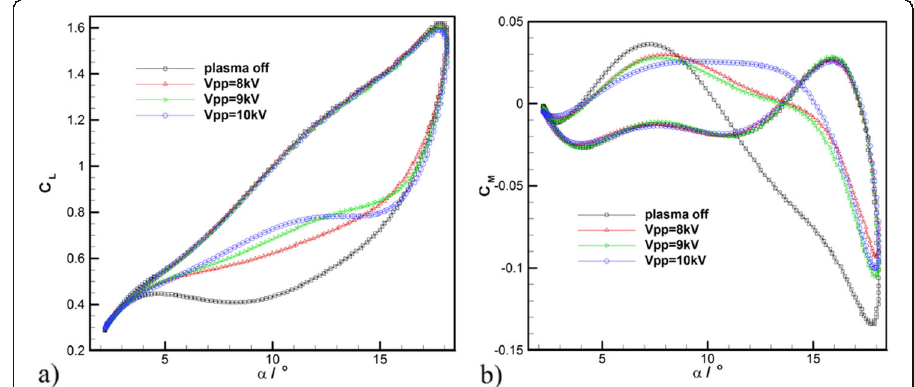
Fig. 8 The effect of actuation voltages on the lift and moment coefficients